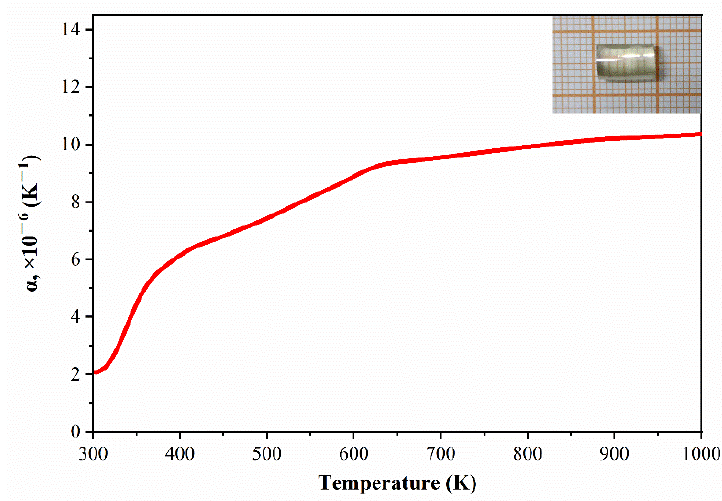
Figure 10. Thermal expansion coefficient of TiO 2 single crystal.